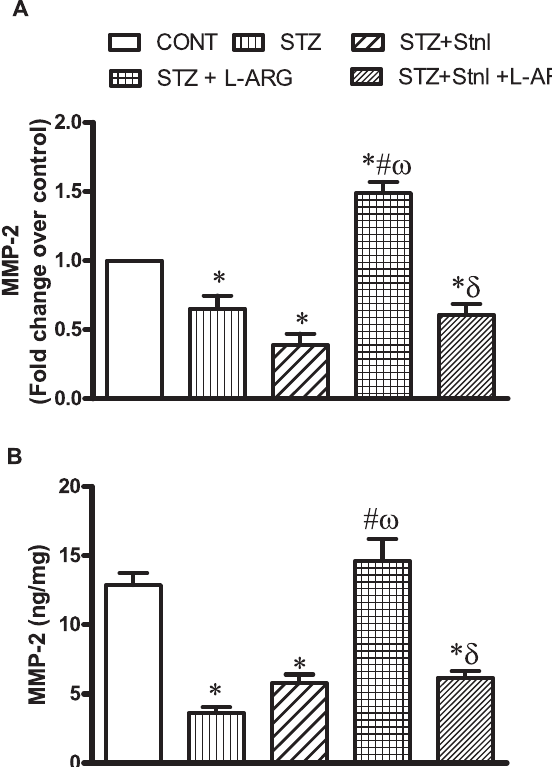
Fig. 3. Effect of STZ alone or in combination with L-ARG or L-ARG + Stnl on metalloproteinase (MMP)-2 mRNA expression (A) and protein content (B). Data represent the means of six experiments ¡ SEM; *, # , v and d P , 0.05 compared with CONT, STZ, STZ + Stnl and STZ + Stnl + L-ARG, respectively, using one-way ANOVA followed by Tukey’s Multiple Comparison